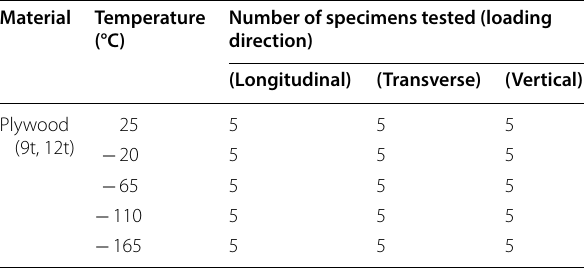
Table 4 Compression test conditions for compressed laminated